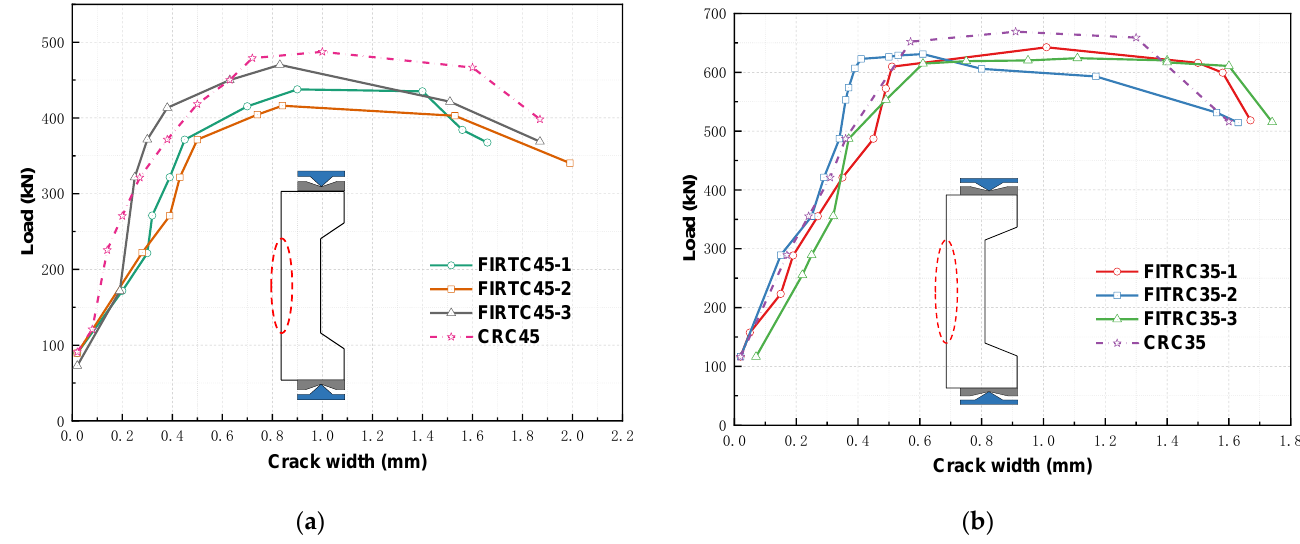
Figure 9. Load–maximum crack width curves of RC columns: ( a ) e 0 / h 0 = 0.60; ( b ) e 0 / h 0 = 0.70.